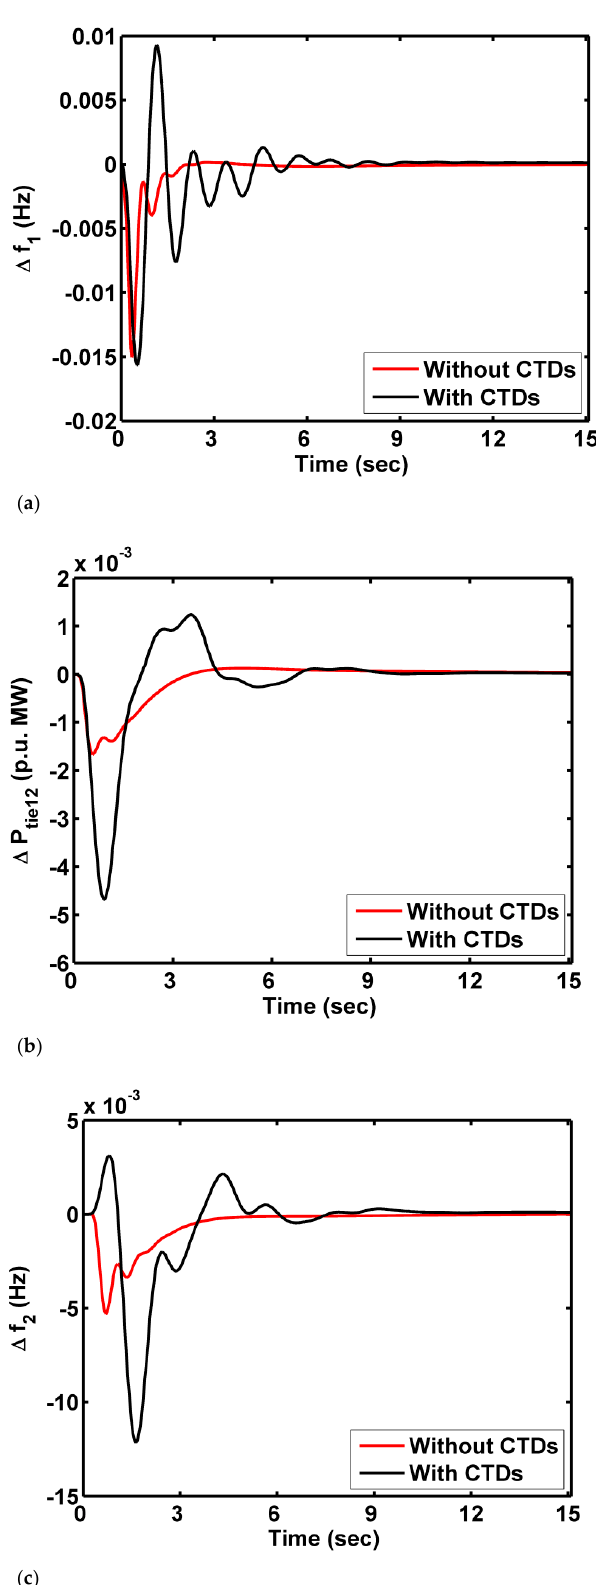
Figure 10. Responses for case 4: ( a ) ∆ f 1 ( b ) ∆ P tie 12 and ( c ) ∆ f 2